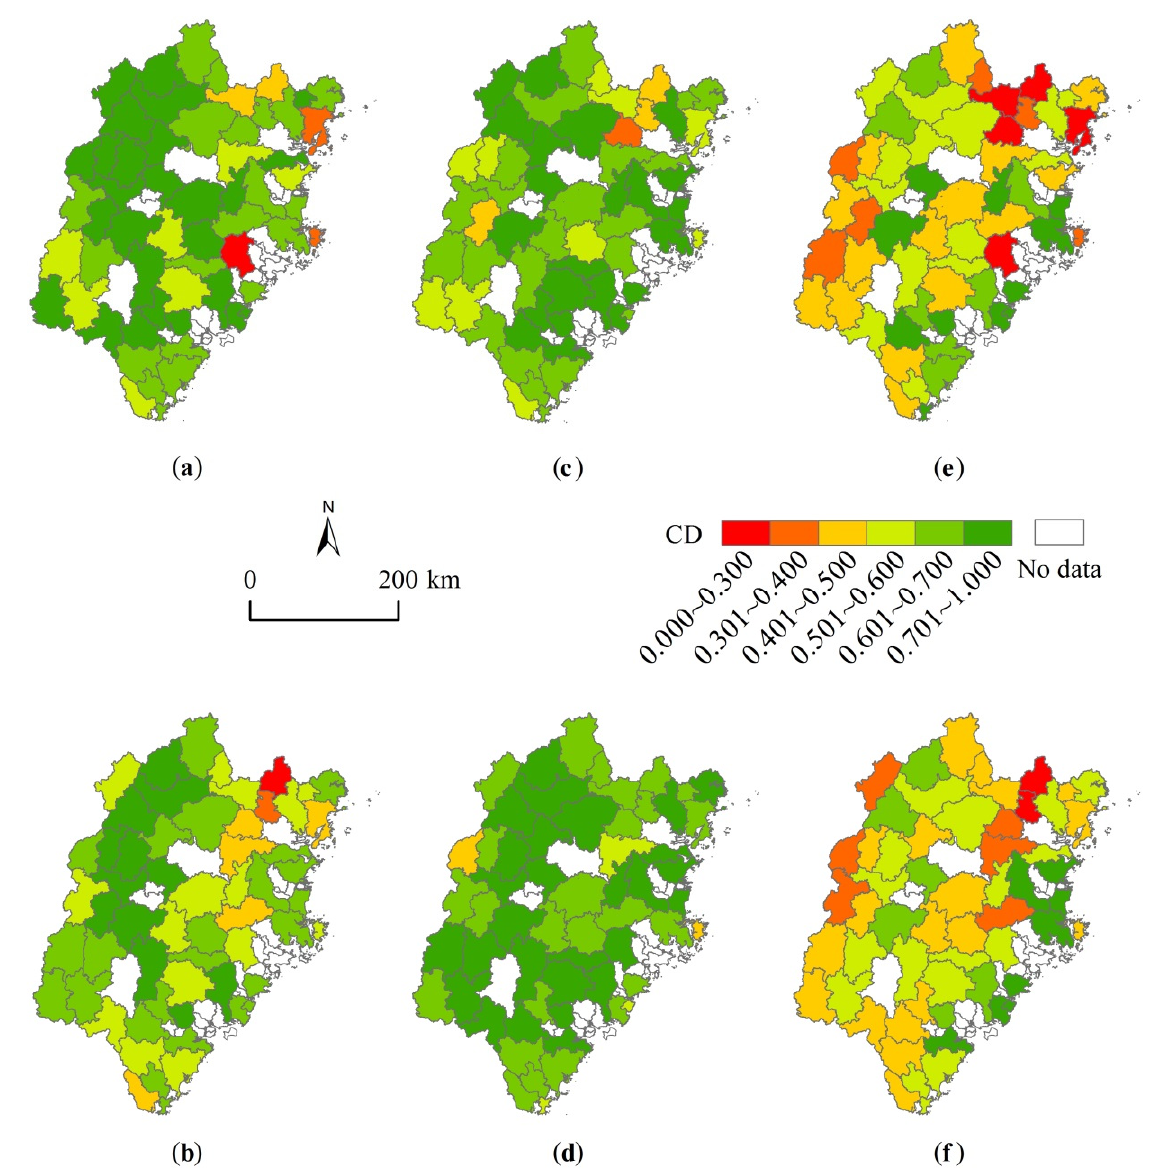
Figure 4. Coordination degree between EI and EC and TR in Fujian province in 2000 and 2018. ( a ) Coordination degree of EI & EC in 2000; ( b ) Coordination degree of EI & EC in 2018; ( c ) Coordination degree of EI & TR in 2000; ( d ) Coordination degree of EI & TR in 2018; ( e ) Coordination degree of EC & TR in 2000; ( f ) Coordination degree of EC & TR in